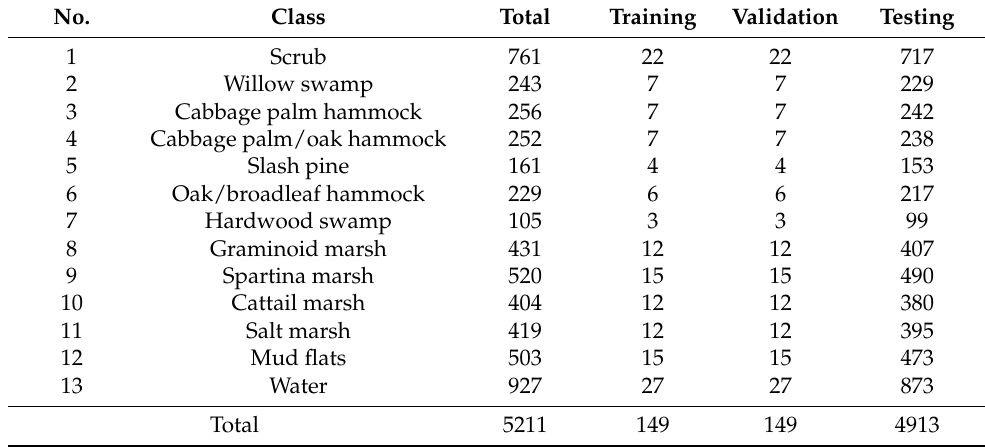
Table 4. Number of training, validation, and testing samples for the KSC